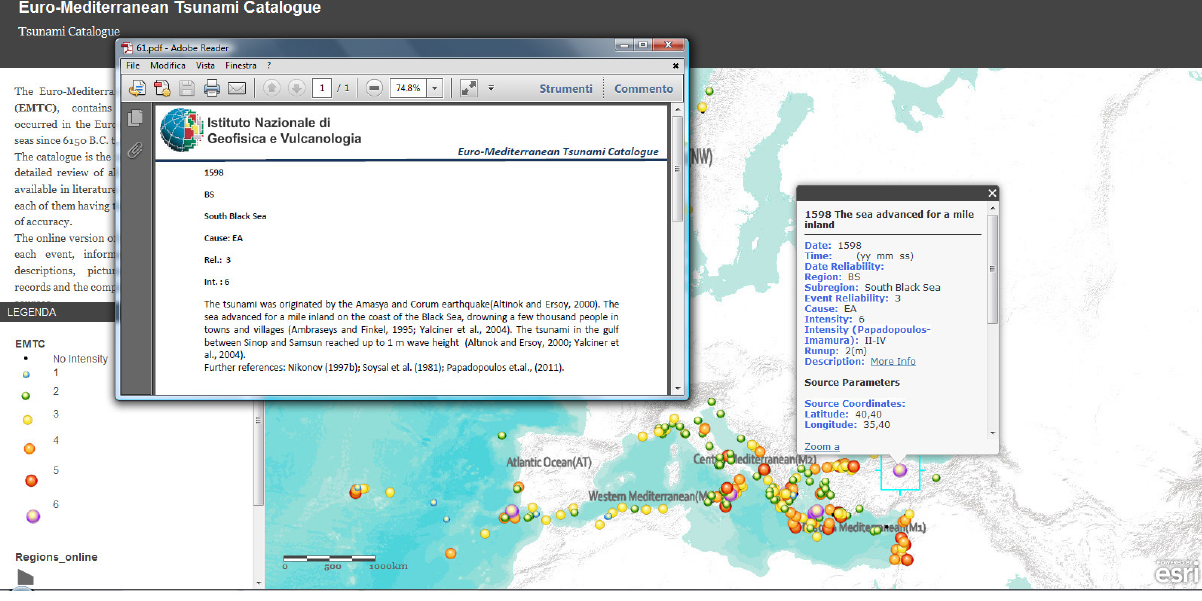
Figure 3. Example of the online version of the